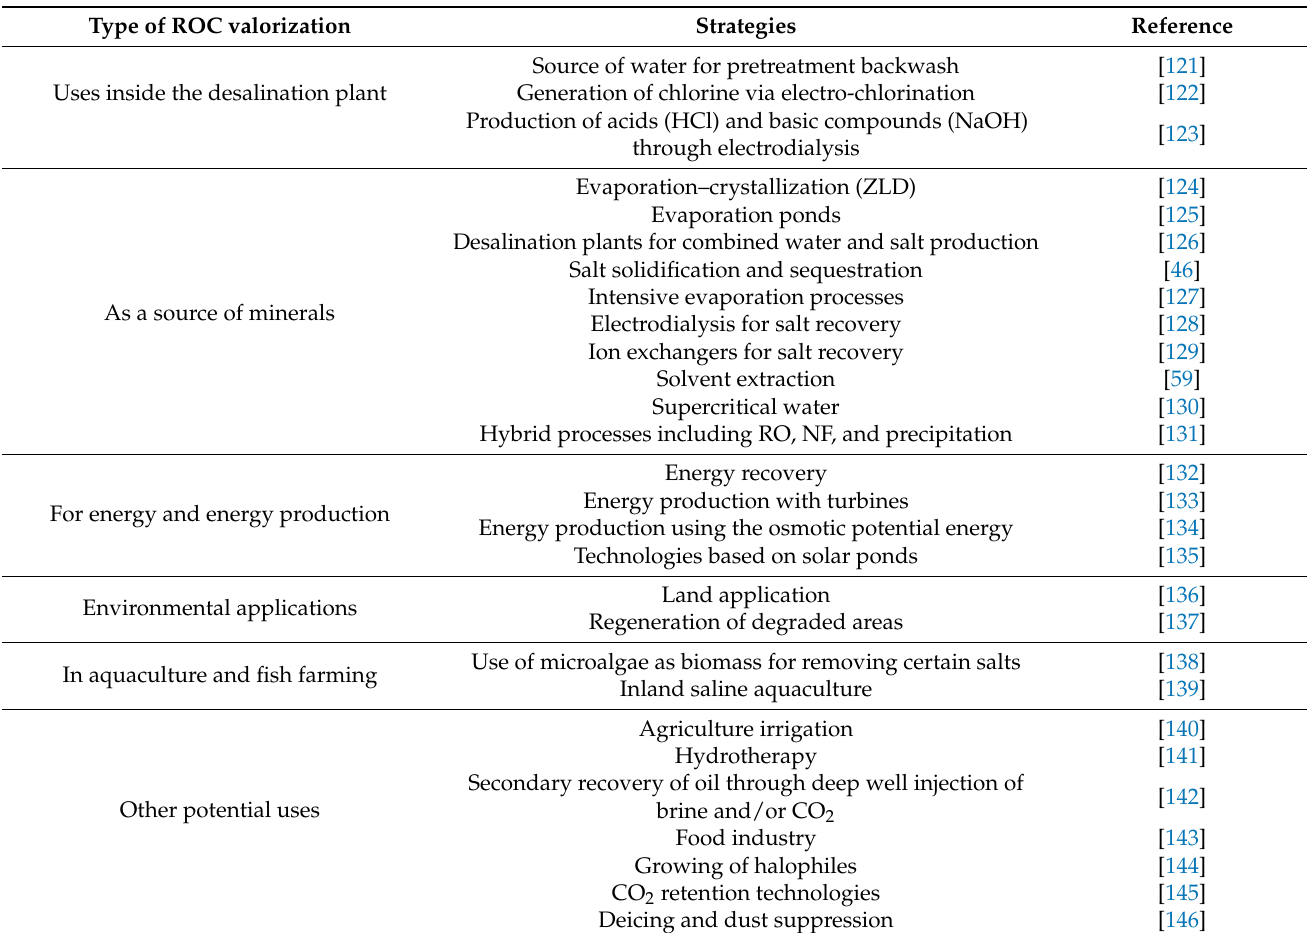
Table 3. List of main ROC valorization strategies (based on